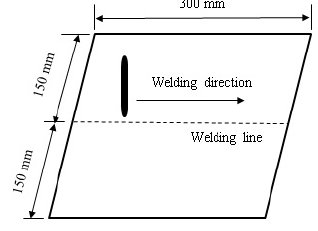
Figure 4. Dimension and welding